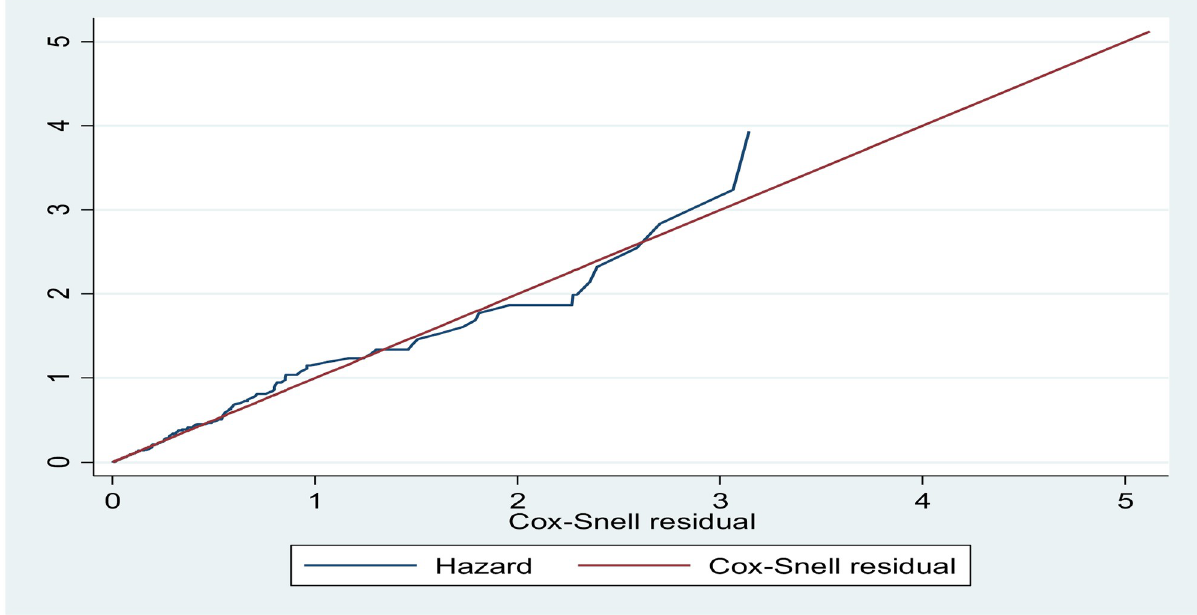
Fig 3. Cox-Snell residual graph, based on the Kaplan–Meier estimated survivor function, to test the overall adequacy of the cox proportional hazard model of time to diabetic neuropathy and its predictors of type 2 DM patients at Amhara region Comprehensive Specialized Hospital, Northwest Ethiopia (n =